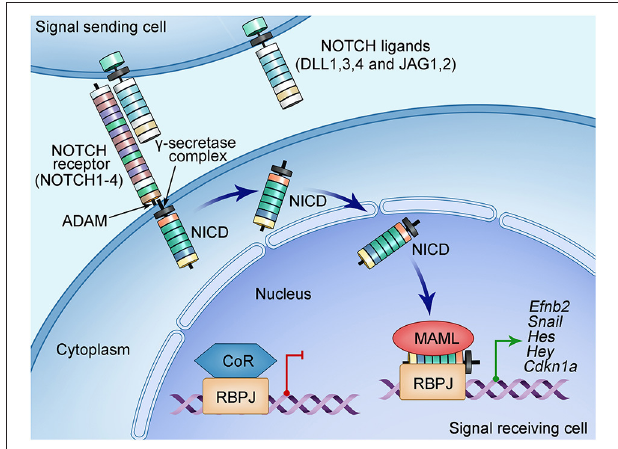
FIGURE 2 | Schematic of NOTCH signaling pathway. NOTCH signaling pathway consists of ligands (DLL1, DLL3, DLL4, and JAG1, JAG2), receptor (NOTCH1-4), nuclear effector RBPJ, and cofactors. Both NOTCH ligands and receptors are type I transmembrane proteins with an extracellular domain consisting of a number of EGF-like repeats modified by sugars essential for the ligand-binding specificity. The NOTCH signal is initiated when the ligand on the surface of the signaling-sending cell binds the NOTCH receptor on the signaling-receiving cell. This ligand–receptor interaction generates a mechanical force that causes the conformational change of the NOTCH receptor, leading to subsequently proteolytic cleavages mediated by disintegrin and metalloproteinase domain-containing protein (ADAM) metalloproteinases and the γ -secretase–presenilin complex. These cleavages on the NOTCH receptor release the NOTCH intracellular domain (NICD), which then translocate into the nucleus and form a transcriptional complex with the DNA-binding protein RBPJ. RBPJ forms a complex with corepressors (CoR) and suppresses the transcription of target genes when NICD is not in the nucleus. The binding of NICD with RBPJ results in the release of CoR, while recruiting the coactivator Mastermind-like protein (MAML), leading to the transcription activation of the target genes such as the HES and HEY families of basic helix–loop–helix transcriptional